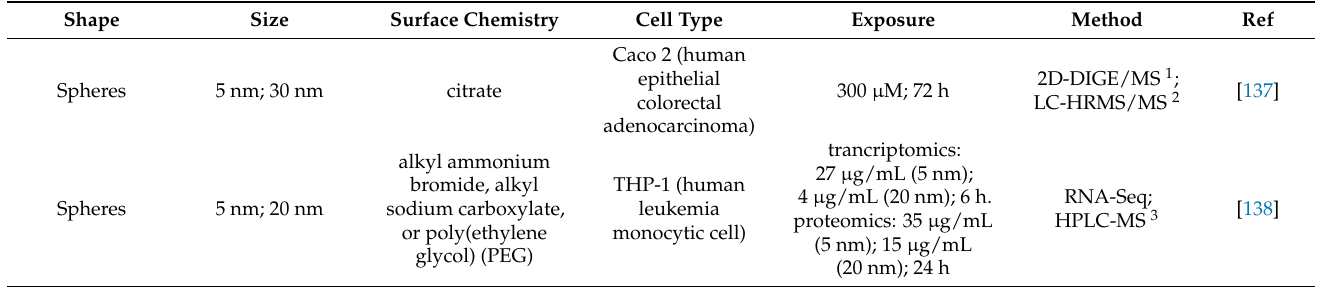
Table 6. Examples of multi-omics studies showing changes induced by AuNPs in